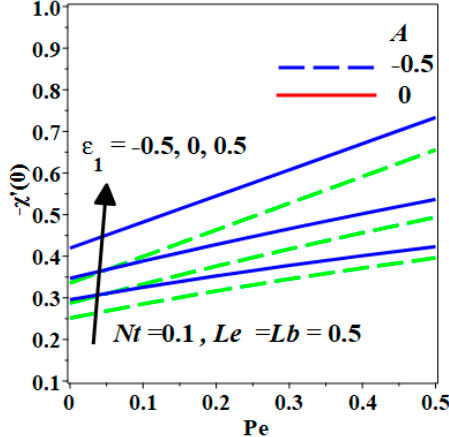
ε on ( ) 0 φ ′− . 1 ε on ( ) 0 φ ′− . 1